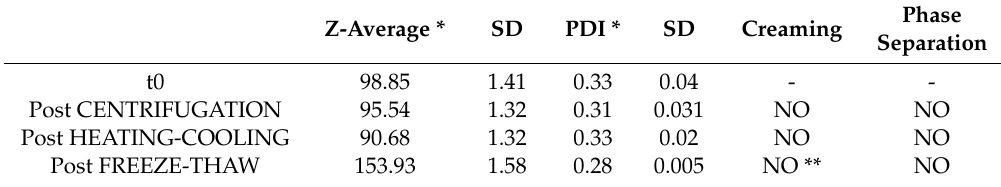
Figure 3. Carlina acaulis essential oil nanoemulsion (EO NE) at t0 ( A ), after the centrifugation ( B ), after the heating–cooling cycles ( C ) and after the freeze-thaw cycles ( D ). Table 1. Thermodynamic stability evaluation, in terms of Z-average, polydispersity index (PDI), creaming, and phase separation, of the Carlina acaulis essential oil (EO) nanoemulsion through the accelerated stability test.